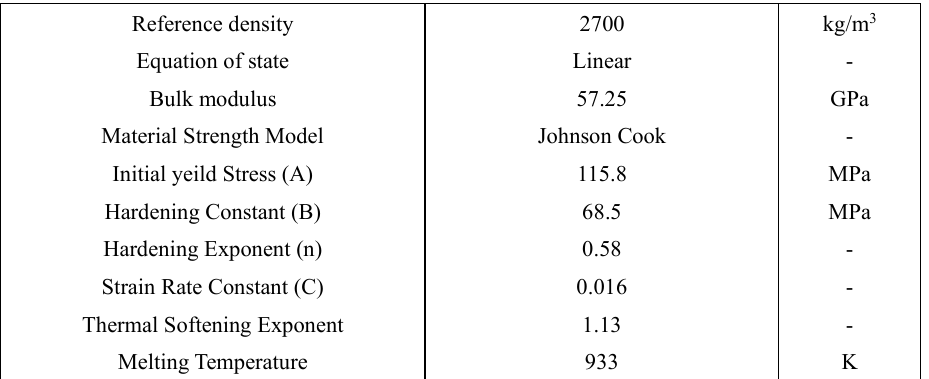
Fig.3. Configuration of numerical analysis model using the random cell model. Table 1. Material property parameters of pure